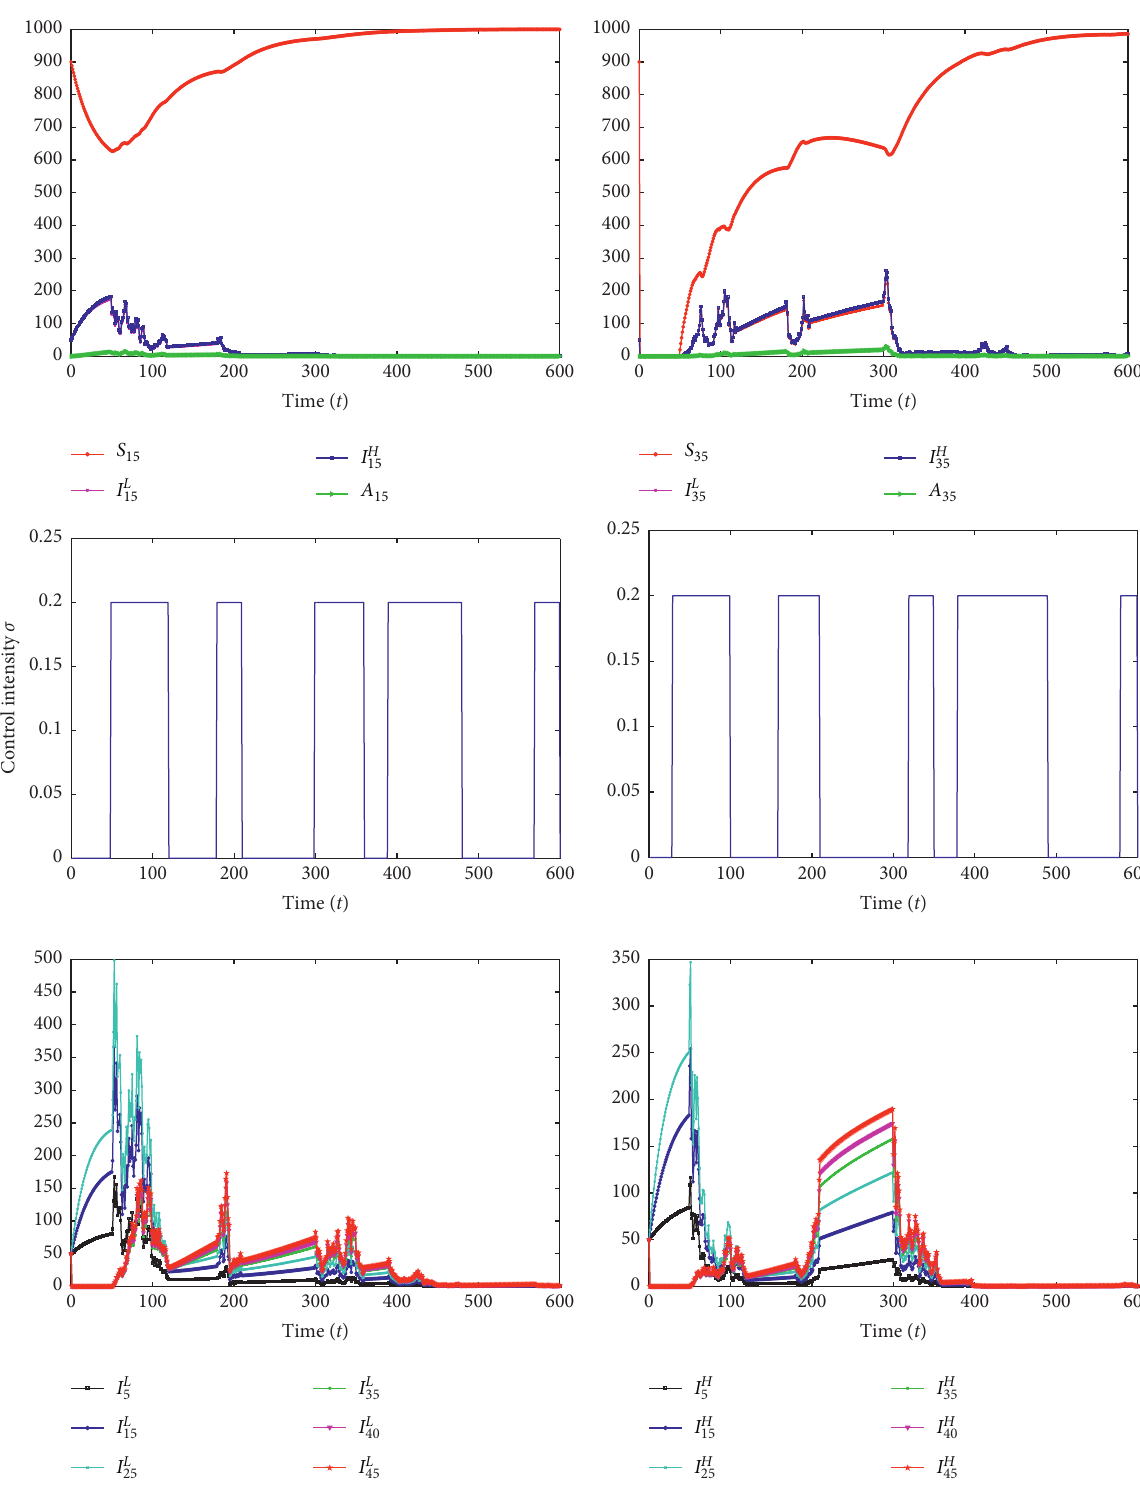
Figure 4: The time series and orbits of system (7) with R > 1 and stochastic control. The top two pictures are the sample paths of 0 S ( t ) ,I L ( t ) ,I H ( t ) ,A ( t ) and S ( t ) , I L ( t ) , I H ( t ) , A ( t ) . The middle pictures are two different time strategies with τ � 0 . 5 and σ � 0 . 2. 15 15 35 35 15 15 35 35 The last two pictures are sample paths of I L ( t ) and I H ( t ) with degree k � 5 , 15 , 25 , 35 , 40 , 45. The malware will be extinct in the